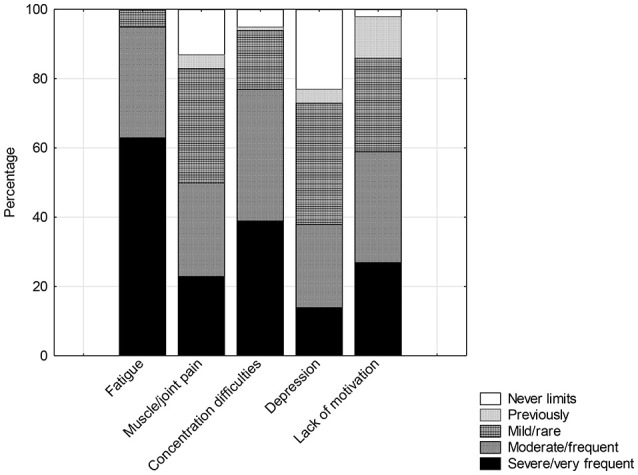
Rating of symptoms limiting functioning.